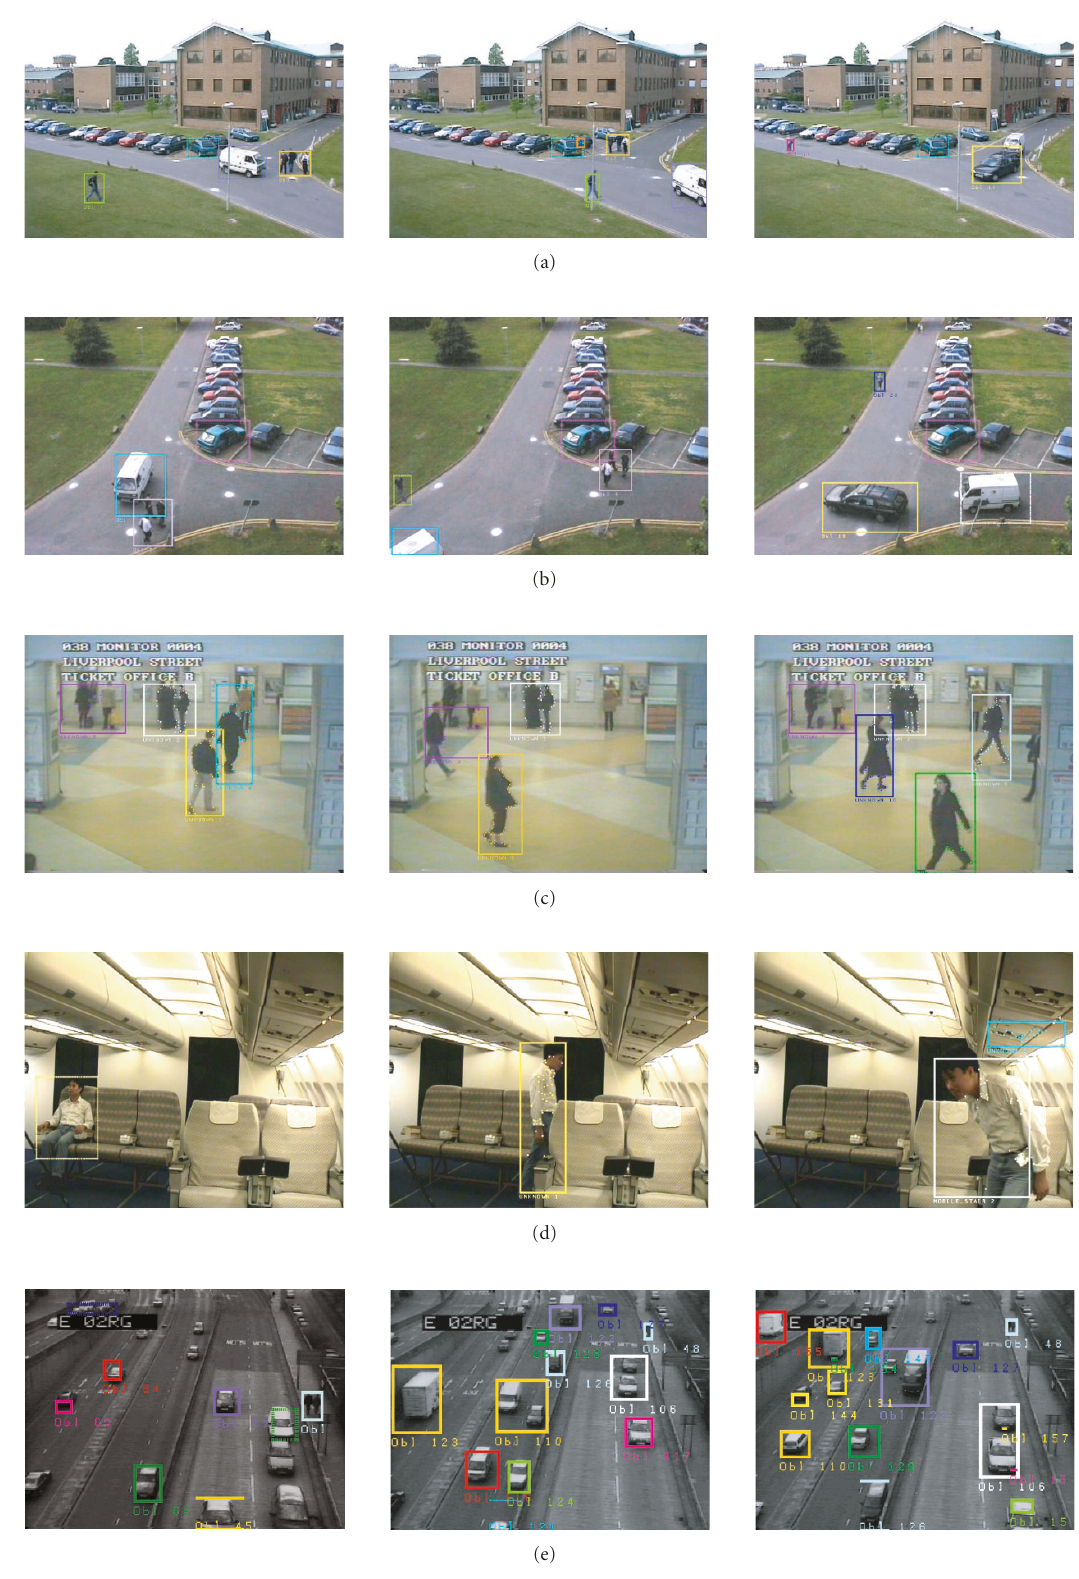
Figure 15: Results of the tracking system running on various datasets. (a) PETS 2001 Dataset 1 Camera 1 frames 875, 988, and 2470; (b) PETS 2001 Dataset 1 Camera 2 and same frames as the previous row; (c) ADVISOR sequence 38 Camera 1 frames 3, 39, and 55 (see [11]); (d) SAFEE sequence EADS Camera 3 frames 260, 330, and 630; (e) tra ffi c sequence frames 607, 1046, and